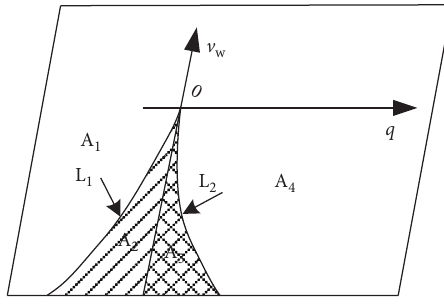
Figure 7: Bifurcation set diagram of mutations surface.